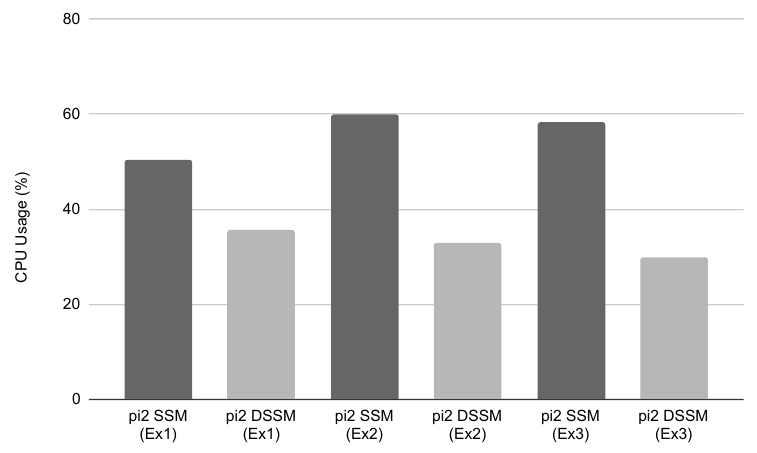
Figure 13. Comparison of CPU usage in Pi2 in all